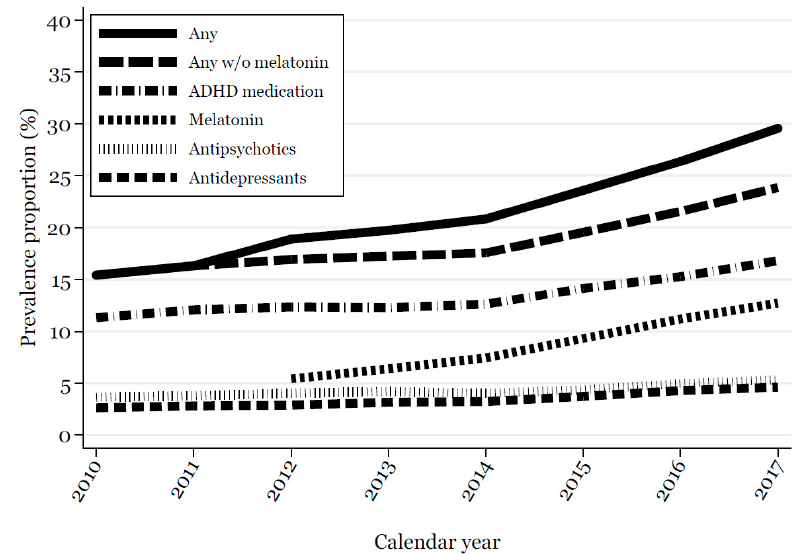
Figure 1. One-year prevalence proportion for the use ( ≥ 2 prescriptions) of attention- deficit/hyperactivity disorder (ADHD) medication, antidepressants, and antipsychotics from 2010 to 2017 and melatonin from 2012 to 2017 in children and adolescents 3–17 years old with autism spectrum disorder (ASD).